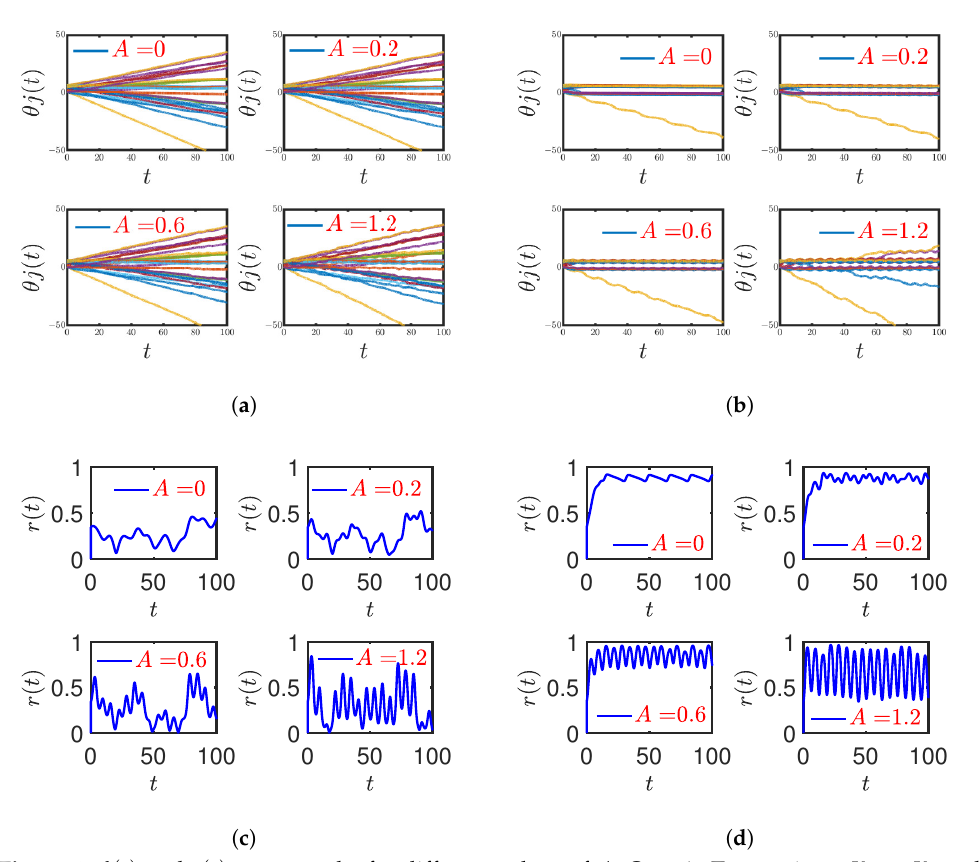
Figure 4. θ ( t ) and r ( t ) vs. t graphs for different values of A , Ω = 1. Two regions, K 1 < K c and K 1 > K c , are tested. ( a ): K 1 = 0.2 < K c forces the oscillators to remain out of synchrony except for some with higher values of A . ( b ): Drifting of some oscillators are associated with the higher values of A (=1.2) even for K 1 = 0.5 > K c . It gives the important indication that the higher A values are destabilizing the synchronization pattern. ( c , d ) are the respective r ( t ) vs. t graphs for K 1 < K c and K 1 > K c